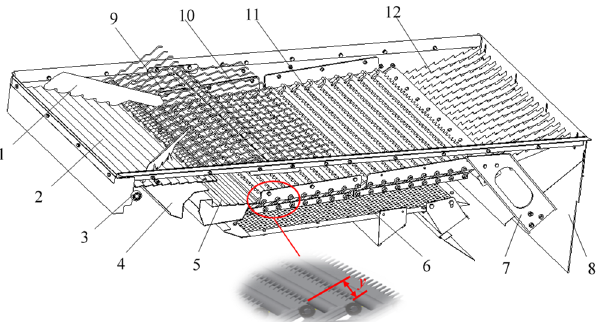
Figure 8. Schematic diagram of the layered impurity-controlled cleaning sieve and the scale sieve’s opening: (1) baffle plate; (2) upper shaking plate; (3) bearing; (4) air deflector; (5) lower shaking plate; (6) round-hole sieve; (7) connecting plate; (8) rubber plate; (9) front finger sieve; (10) back finger sieve; (11) scale sieve; (12) saw-teeth sieve.